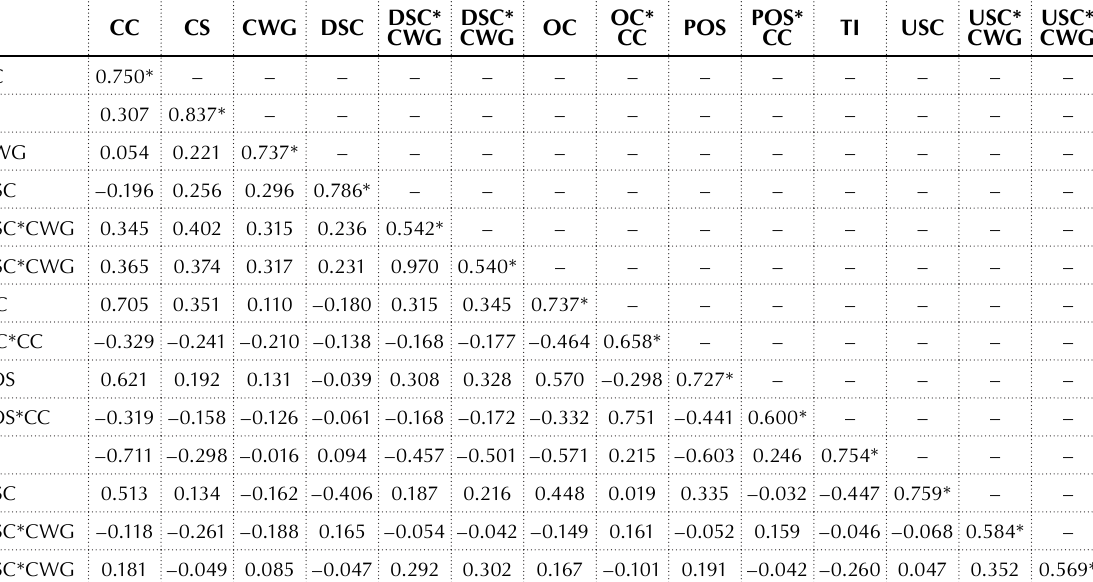
Table 1. Inner model